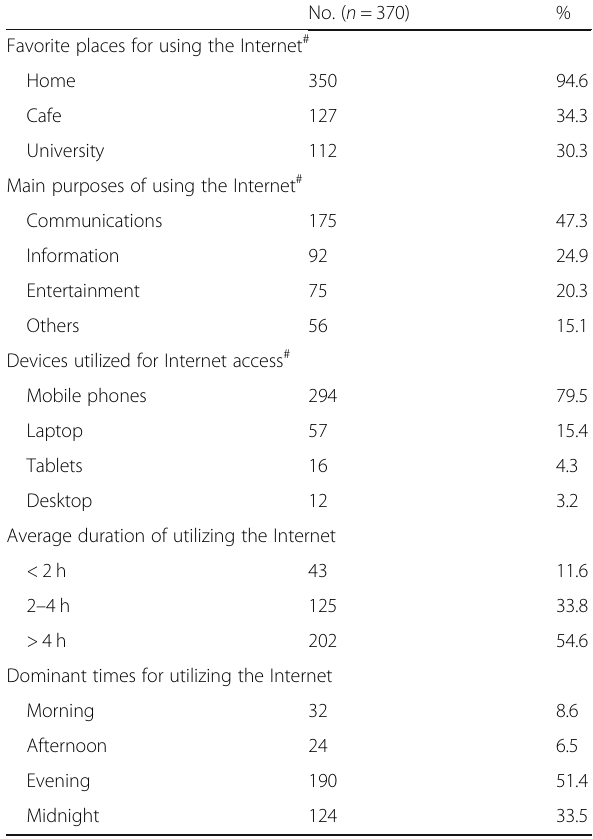
Table 2 Pattern of Internet use of female students at